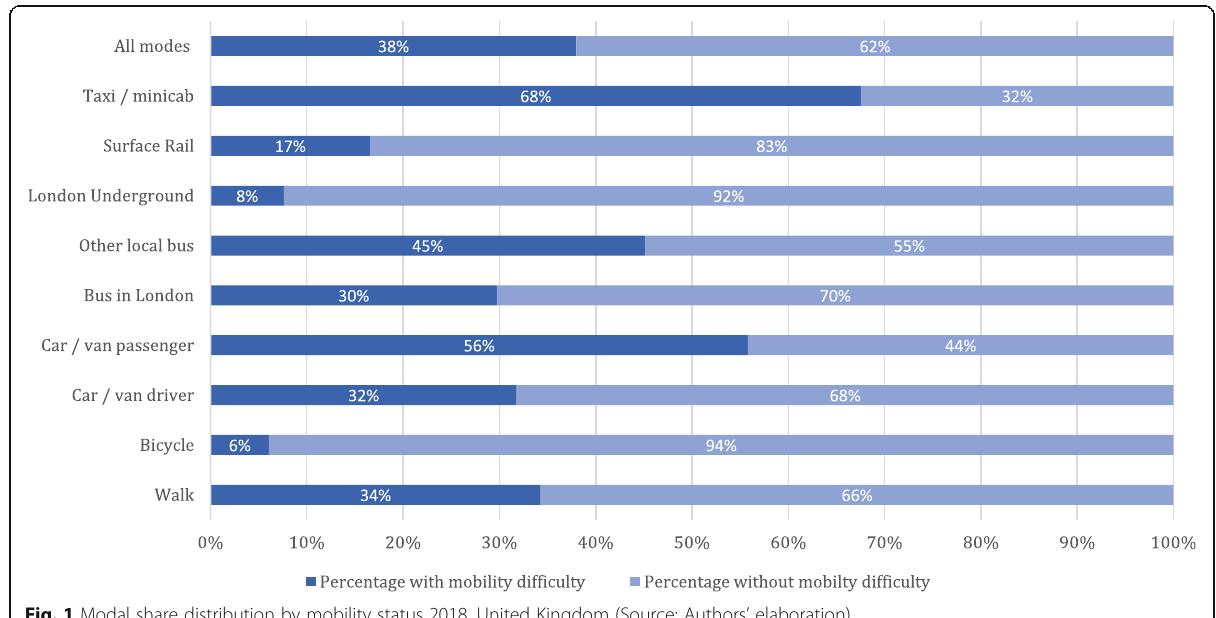
Fig. 1 Modal share distribution by mobility status 2018, United Kingdom (Source: Authors ’